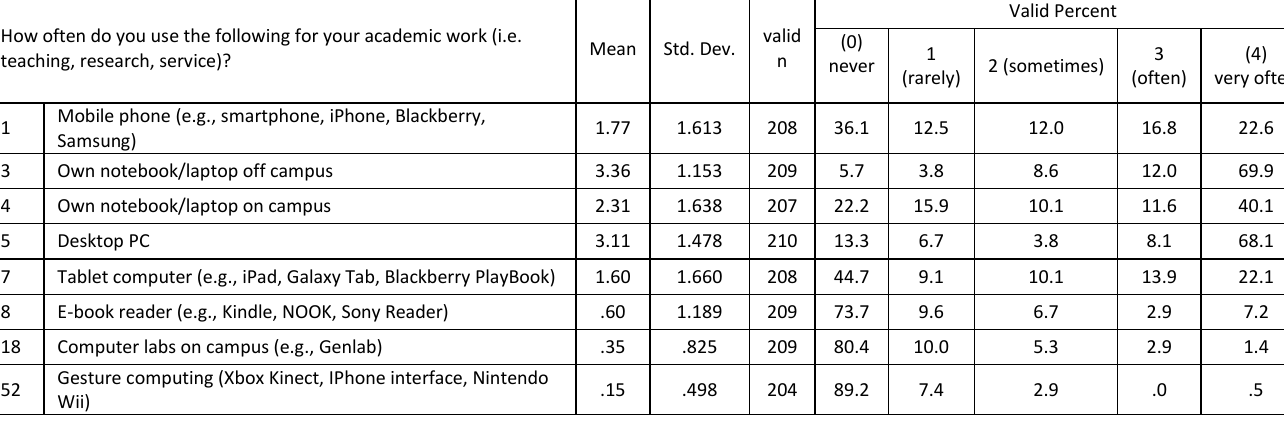
Table 6. Instructors’ responses to the questio n: How often do you use the following for your academic work (i.e., teaching, research, service)?